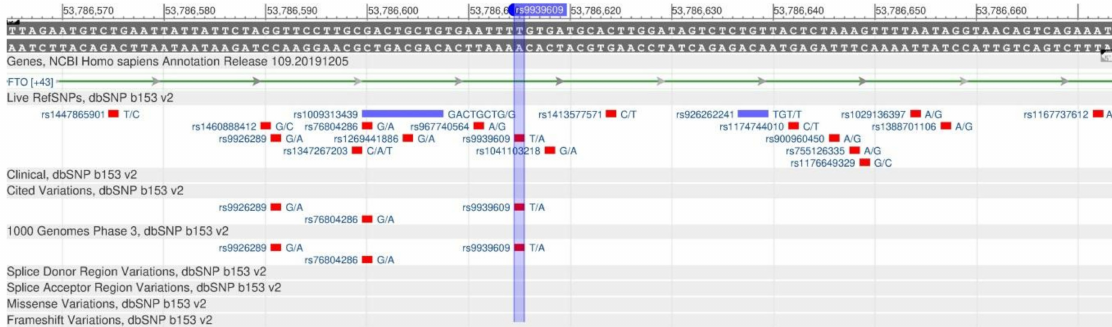
Figure 33. A portion of the FTO gene (located on the long (q) arm of chromosome 16) containing the oligonucleotide polymorphism rs9939609.